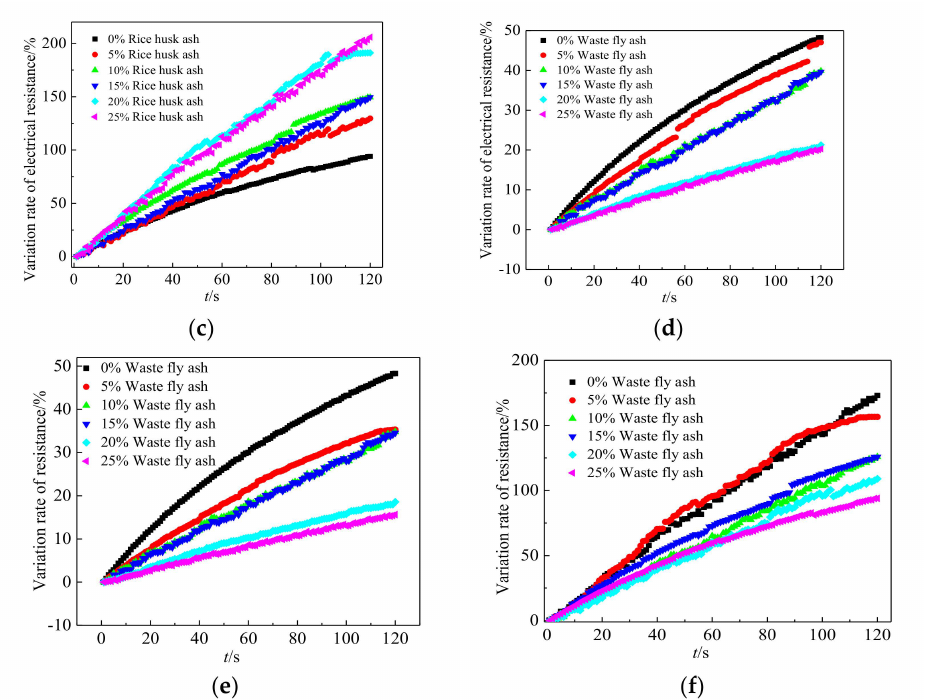
Figure 12. DC electrical resistance–time curves of steel bar-reinforced RPC. ( a ) RPC with rice husk ash after standard curing for 28 days. ( b ) RPC with rice husk ash after standard curing for 28 days after 200 NaCl freeze–thaw cycles. ( c ) RPC with rice husk ash after 20 NaCl dry–wet alternations. ( d ) RPC with waste fly ash after standard curing for 28 days. ( e ) RPC with waste fly ash after 200 NaCl freeze–thaw cycles. ( f ) RPC with waste fly ash after 20 NaCl dry–wet